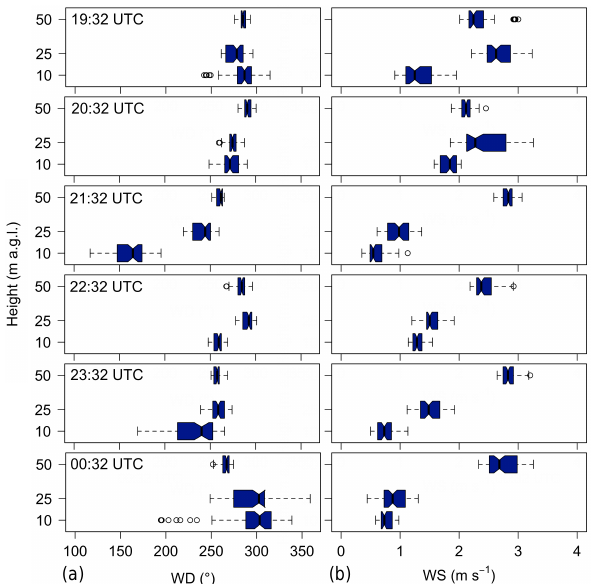
Figure 9. Variability of wind direction (a) and speed (b) during 60s hovering at 10, 25 and 50ma.g.l. for flights between 19:32 and 00:32UTC on the night of 21 to 22 July 2015. The blue box con- tains 50% of the data and represents the interquartile range with the median as a black line. The dashed lines show maximum and minimum values in case those values are within the 1.5 interquar- tile range. Values outside this range (outliers) are represented with